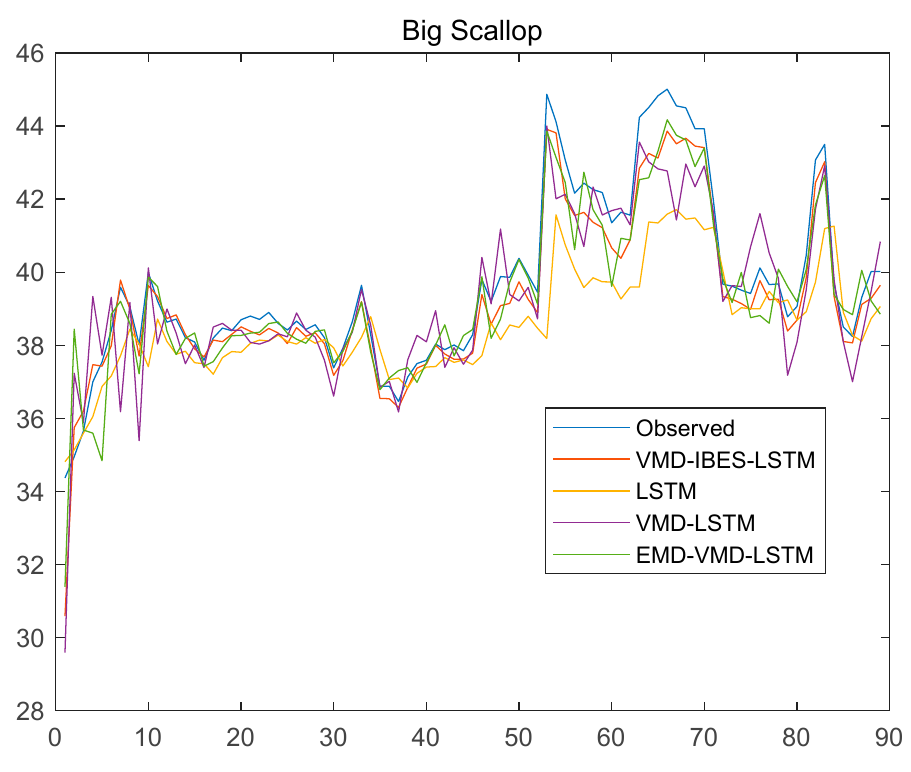
Figure 12. Fitting images of each model.